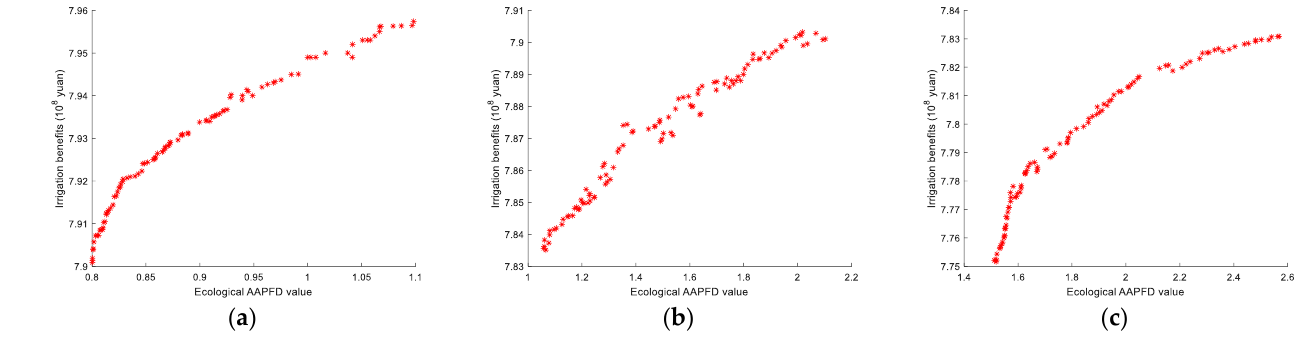
Figure 6. Pareto solution sets for different typical years: ( a ) normal year; ( b ) dry year; ( c ) extraordinary dry year.